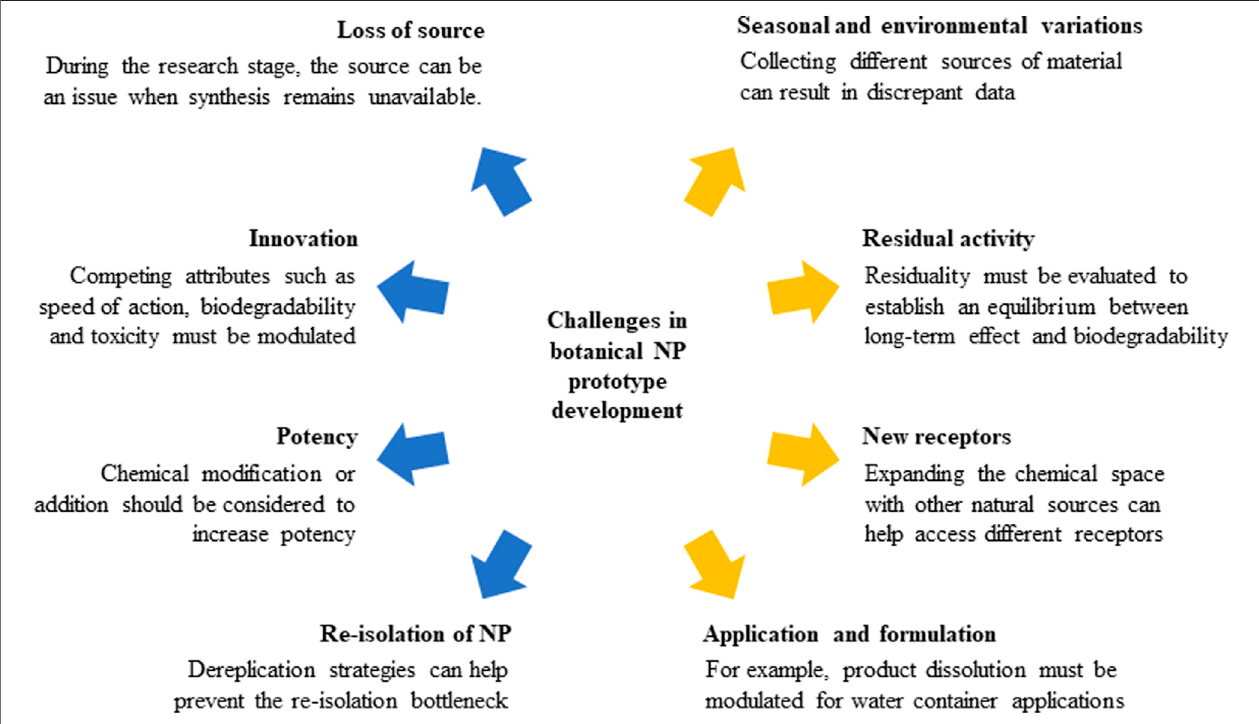
FIGURE 4 | Bottlenecks that NP chemistry needs to address to develop agents against arbovirus vectors.